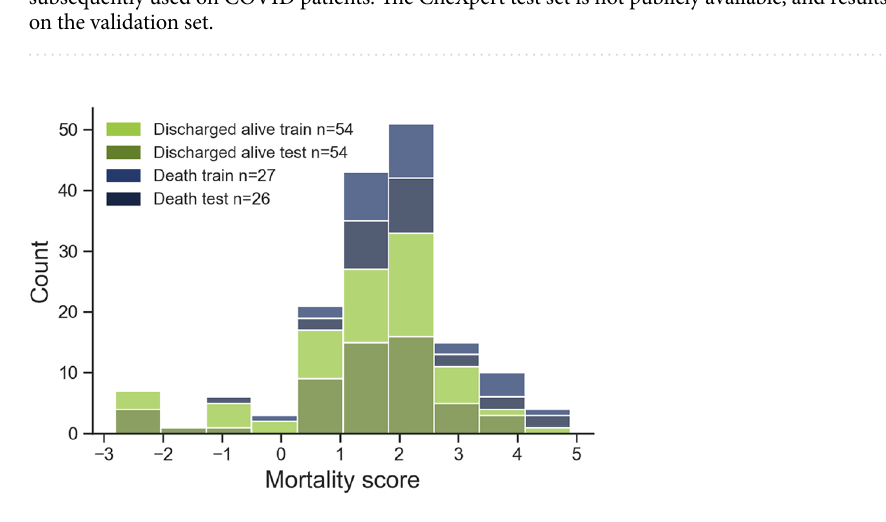
Figure 3. Distribution of the mortality score in the train and test split of the dataset. The split is done using stratified sampling (on the basis of the mortality score) to limit small-sample variance. Deaths and survivals were evenly split between training and